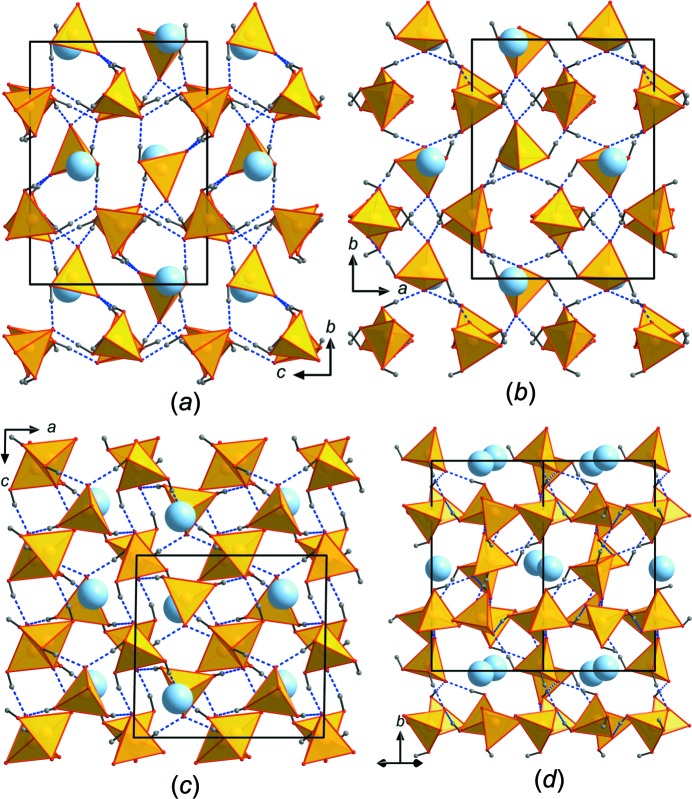
Structural drawings of novel Cs(H2AsO4)(H3AsO4)2, viewed along (a) a, (b) c, (c) b and (d) [101]. The unit cell is outlined. AsO4 tetra­hedra (yellow) are connected via multiple hydrogen bonds (blue) into a 3D network. The Cs+ cations lie between the AsO4 tetra­hedra.